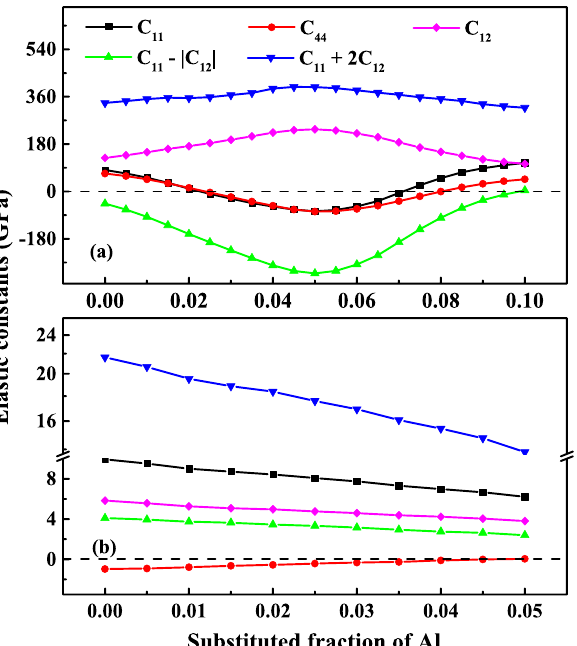
Figure 6. Mechanical stability criteria as a function of composition: ( a ) ordered β 0 -type Ti 0.5 (Al 0.5−x V x ) (x = 0–0.1), ( b ) disordered β-type Ti 0.5 (Al 0.5−y V y ) (y = 0–0.05).